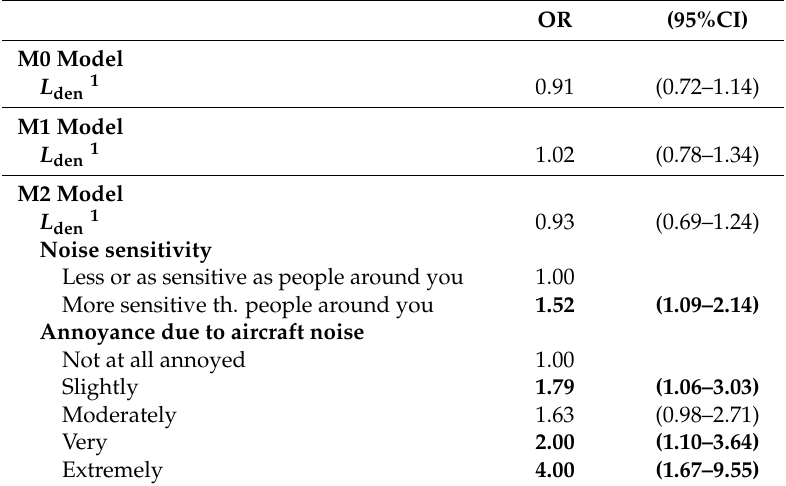
Table 3. Odds ratios (ORs) for the relationship between aircraft noise exposure and psychological ill-health.